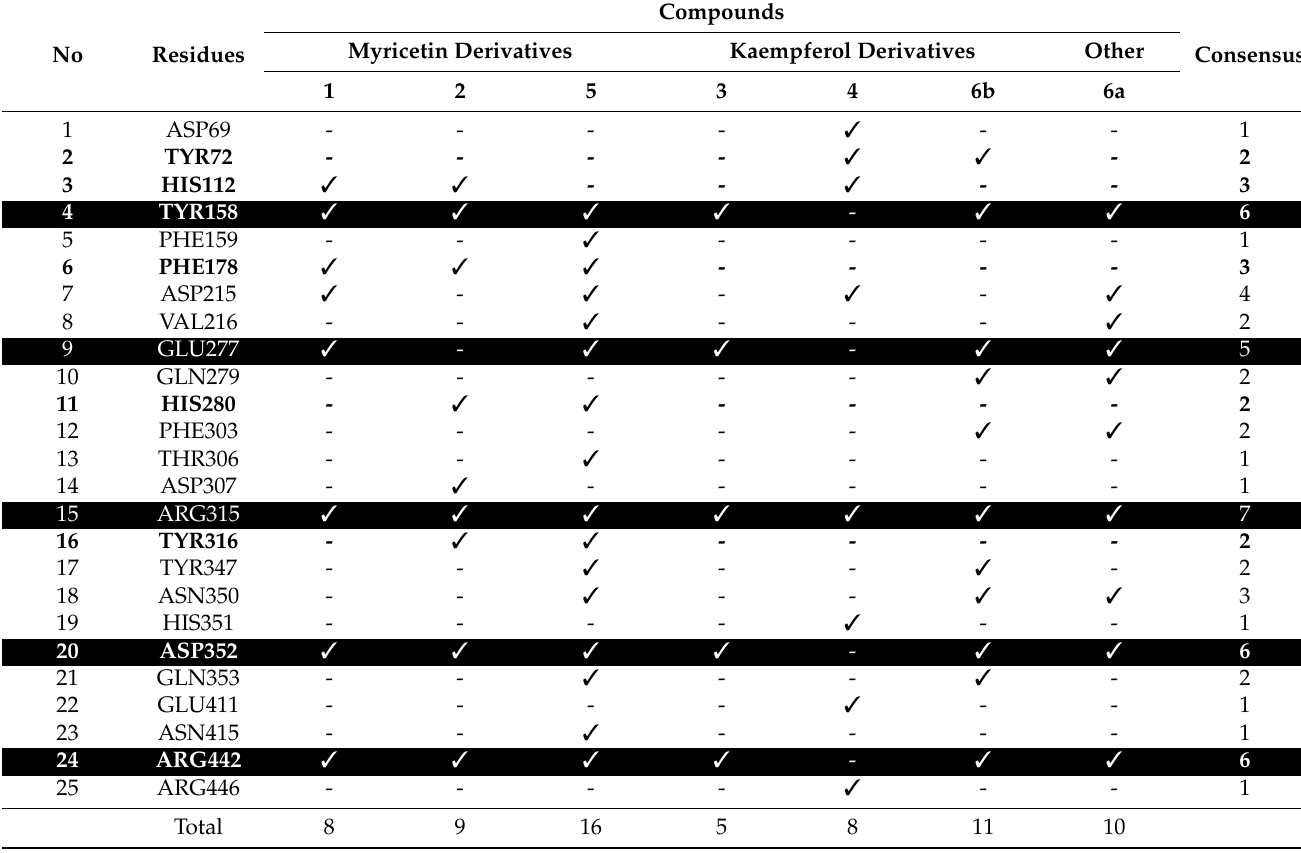
Table 4. Molecular interactions between amino acid residues from alpha-glucosidase and compounds of interest and conserved